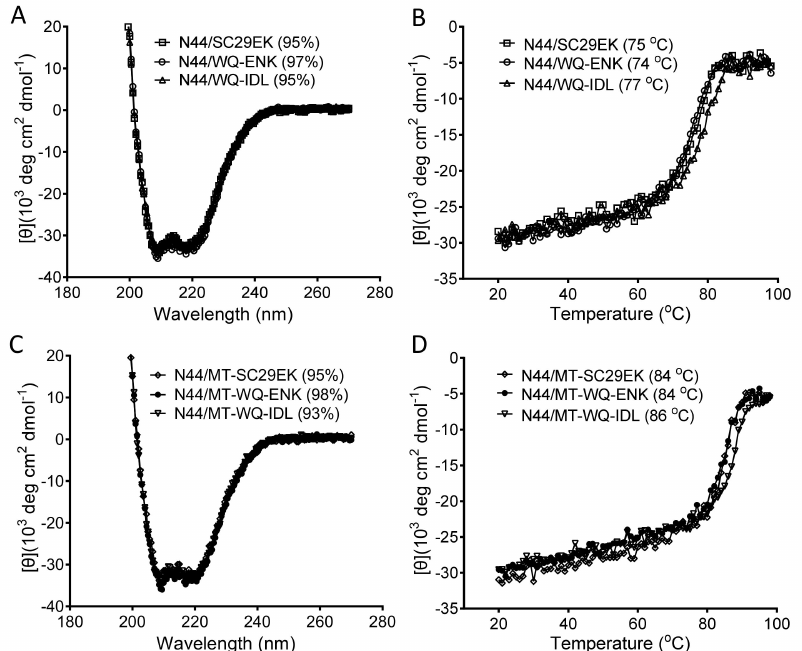
Figure 8. The α -helicity and binding stability of the inhibitors with a C-terminal Asn-145 or IDL anchor. The α -helical contents ( A ) and thermostabilities ( B ) of SC29EK, SC29-ENK, and WQ-IDL in the presence of the NHR-derived target mimic peptide N44 and the α -helical contents ( C ) and thermostabilities ( D ) of the M-T hook-modifiedinhibitorsMT-SC29EK,MT-SC29-ENK,andMT-WQ-IDLinthepresenceofN44wererespectively determined by circular dichroism (CD) spectroscopy. The final concentration of each peptide was 10 µ M in PBS. The experiments were repeated two times, and representative data are